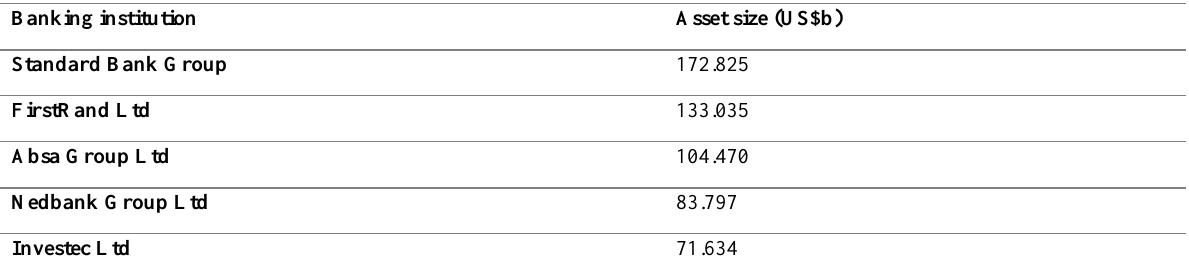
Table 1: Biggest 5 Banks by Asset